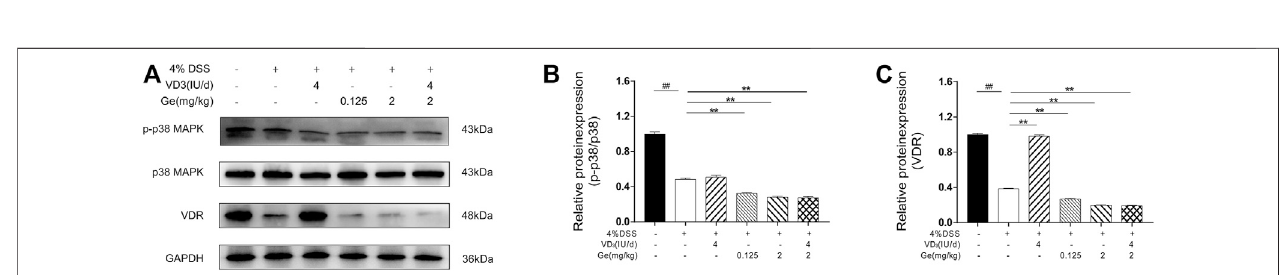
FIGURE 6 | Geniposide attenuated the effects of vitamin D 3 by inhibiting p38 MAPK pathway and then downregulating the expression of VDR. (A) Expressions of p-p38 MAPK, p38 MAPK, and VDR analyzed by Western Blot. (B) Relative expressions of p-p38 MAPK and p38 MAPK. (C) Relative expression of VDR. n (cid:1) 3 per each